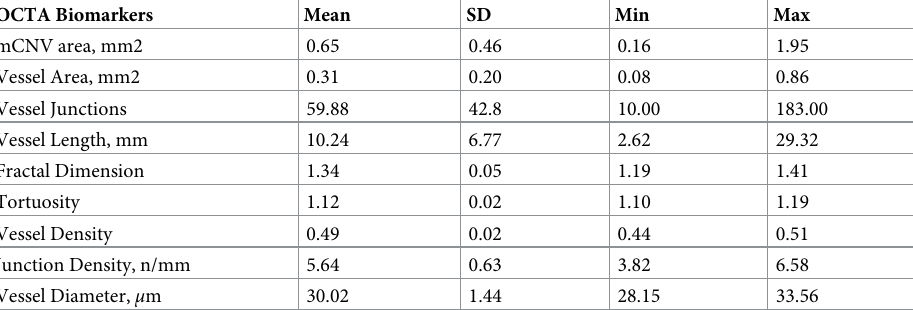
Table 2. Statistical analysis of OCTA biomarkers on the 26-image dataset. OCTA